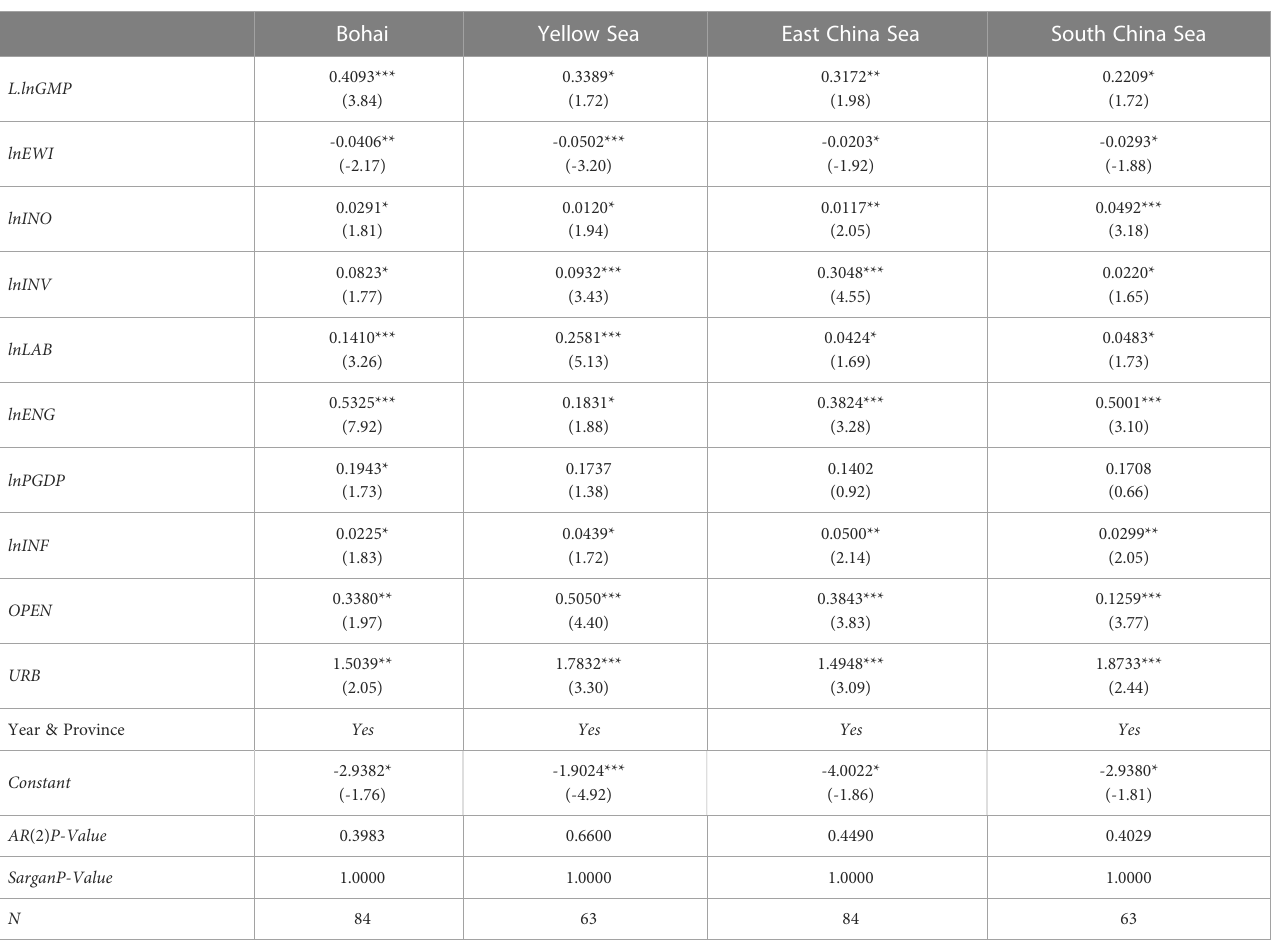
TABLE 3 Heterogeneity analysis of the four sea